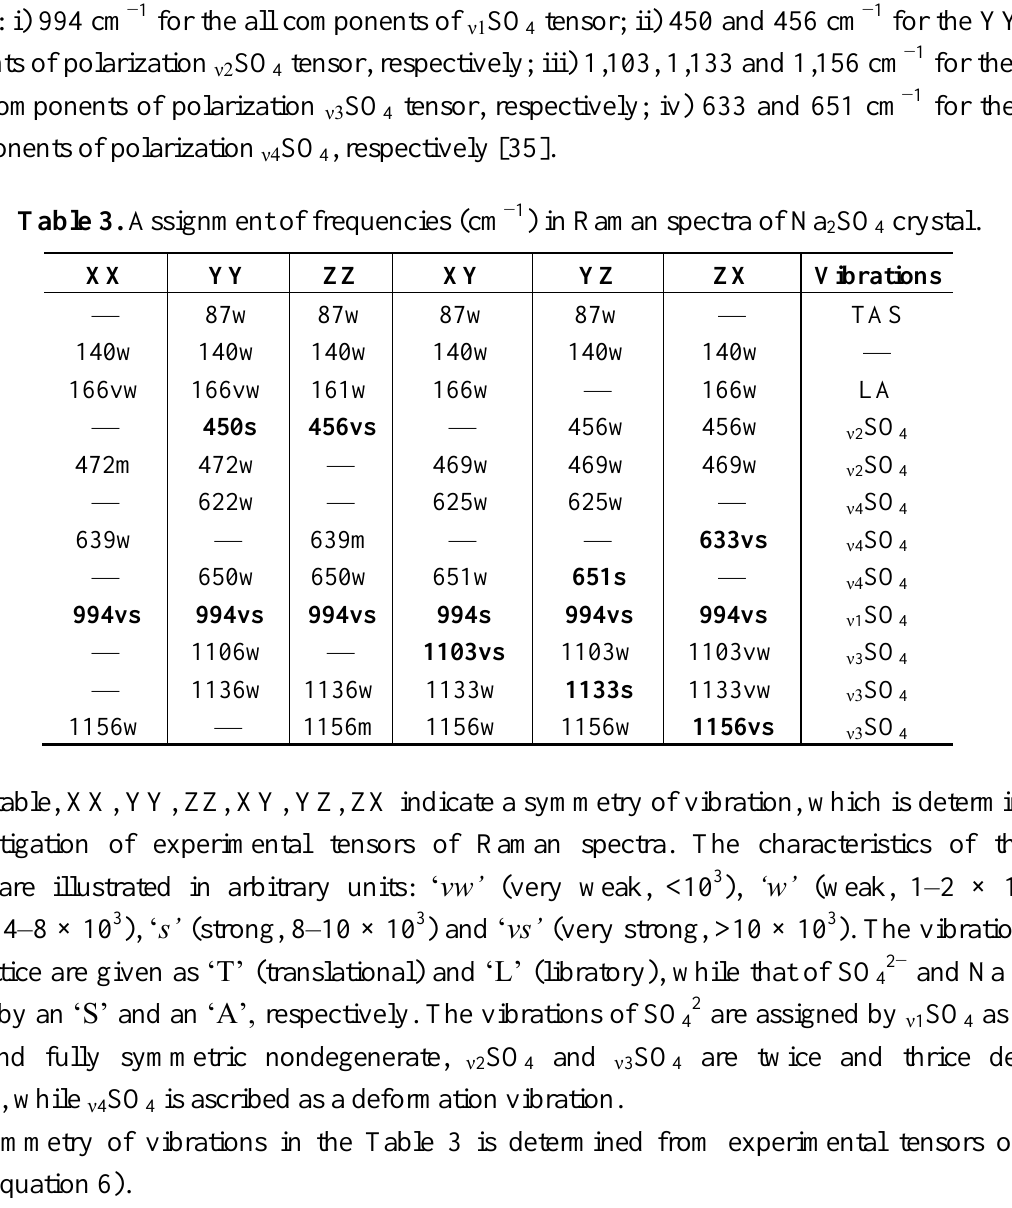
Table 3. Assignment of frequencies (cm −1 ) in Raman spectra of Na